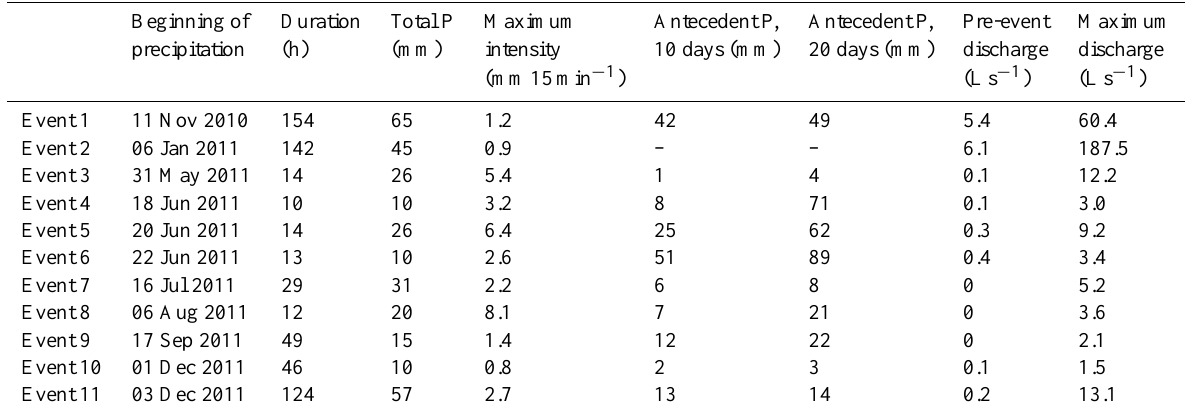
Table 4. General hydrological characteristics of the sampled rainfall-runoff events that occurred from October 2010 to December 2011 in the Weierbach